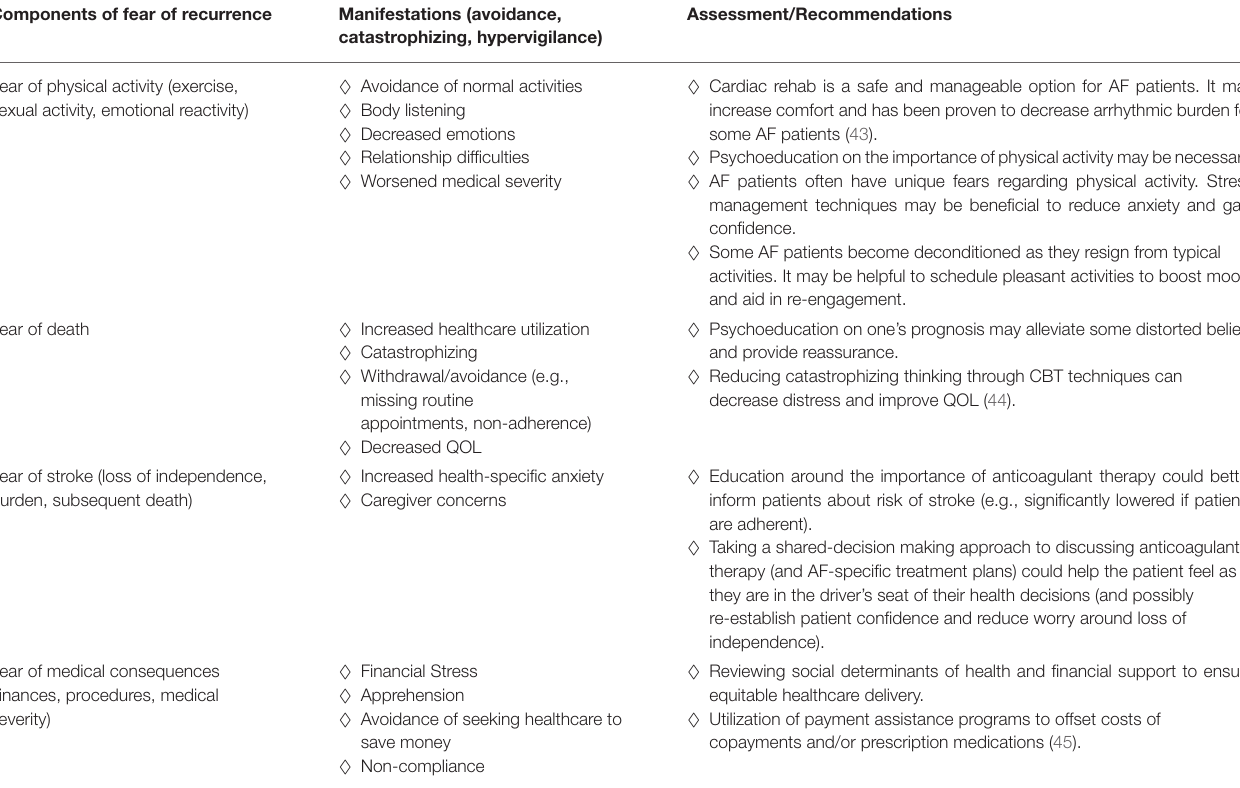
TABLE 1 | Signs, symptoms, and steps for identifying and targeting AF patient fears. Components of fear of recurrence Manifestations (avoidance, catastrophizing,